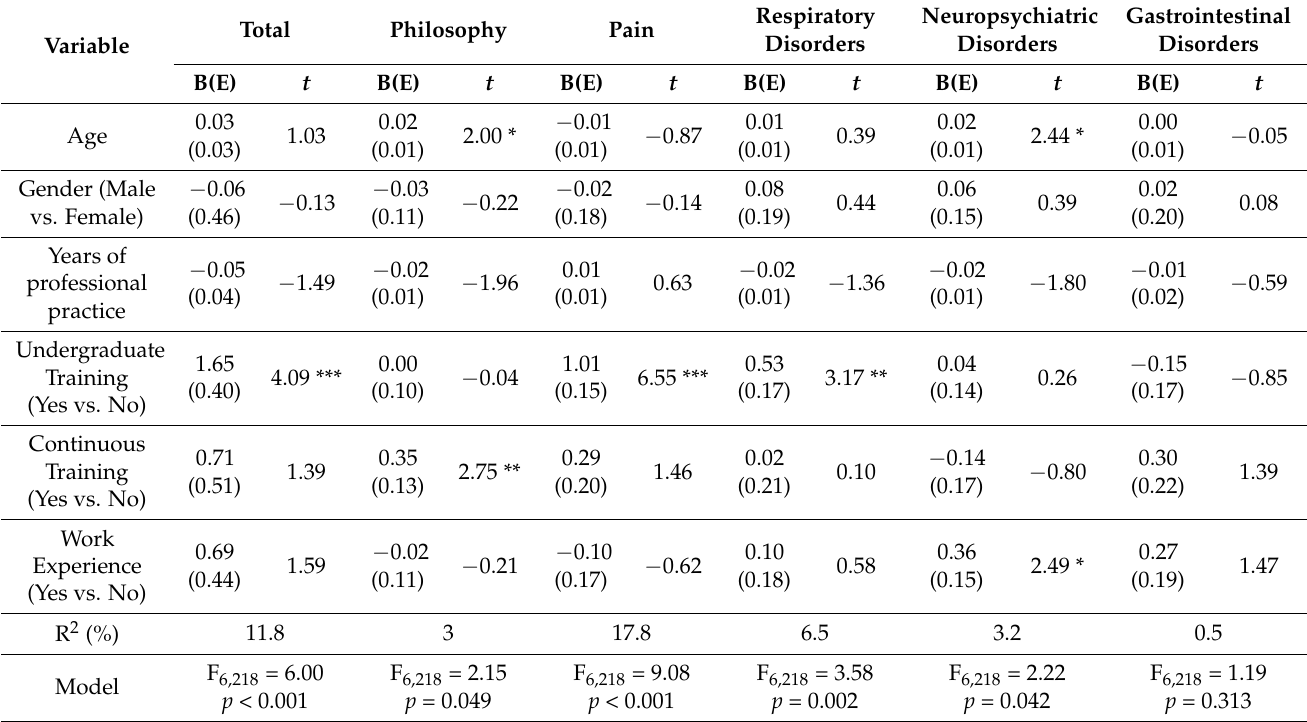
Table 7. Multiple-dimensional regression models of the Palliative Care Knowledge Test-Spanish Version in